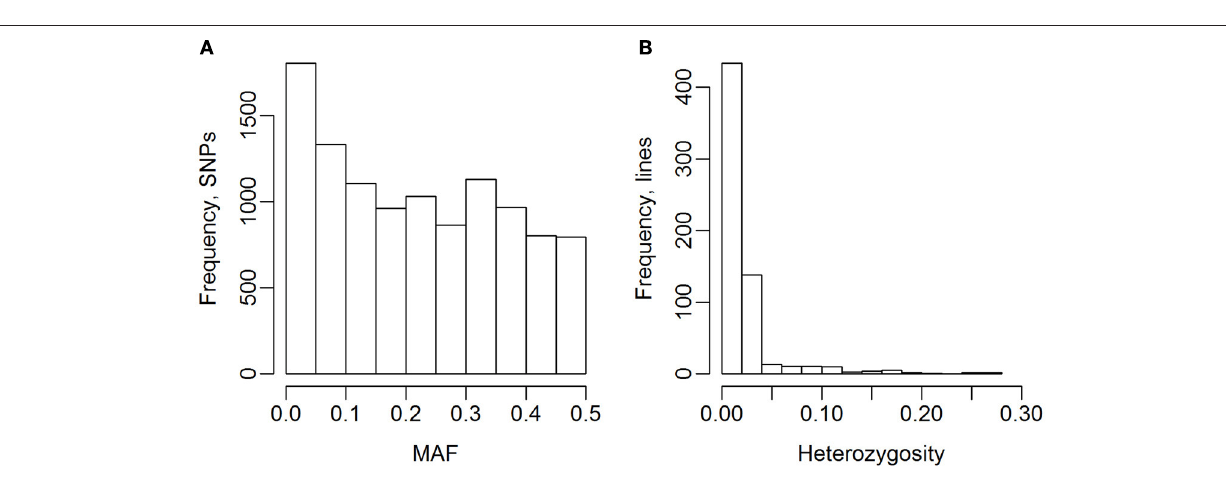
of 89% for the advantageous allele ( Figure 5D ). No significant SNPs, these regions explained 3.2, 6.5, and 9.2% of the genetic SNPs were found for falling number when analyzing all 635 variance for Zeleny sedimentation, respectively. The frequencies lines, but using only lines from set2014 (321 lines) revealed of the alleles associated with higher Zeleny sedimentation were one significant SNP on chromosome 4DS ( p -value 64% (1B), 14% (1D), and 28% (5D). with an advantageous allele frequency of 77% (results not For falling number, a nearly significant region was found on chromosome 7B ( p -value 4.3 ∗ 10 − 5 ) with an allele frequency =